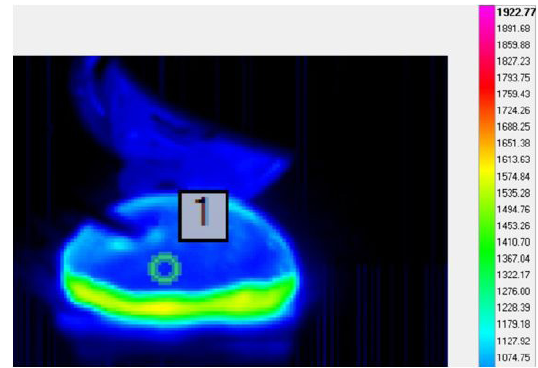
Figure 3. [1] Melted 309L-Si filmed for determination of his